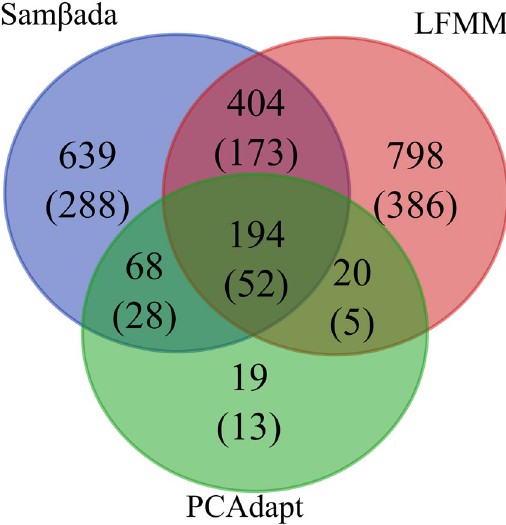
Figure 4. Overlapping SNPs identified by the three genome-scan methods. Numbers in the intersection regions represent overlapping SNPs among two or three methods. Numbers in parentheses show the corresponding genomic regions harbouring the SNPs.